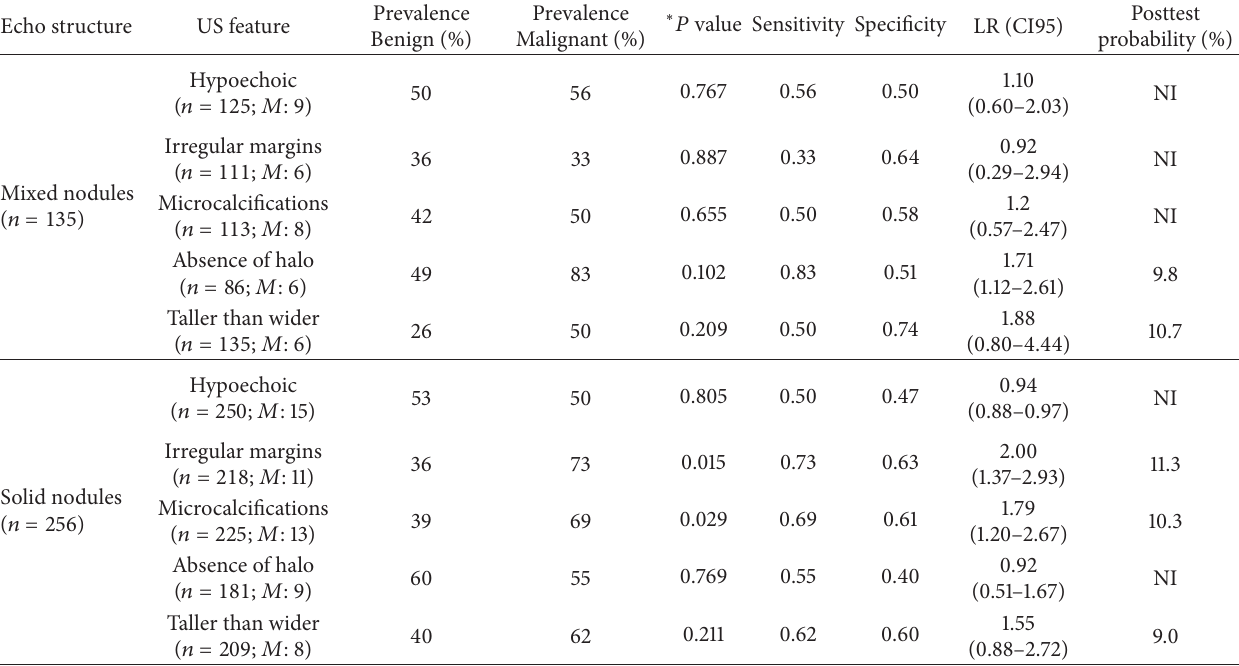
Table 3: Associations between US features with malignant cytology in mixed and solid nodules.